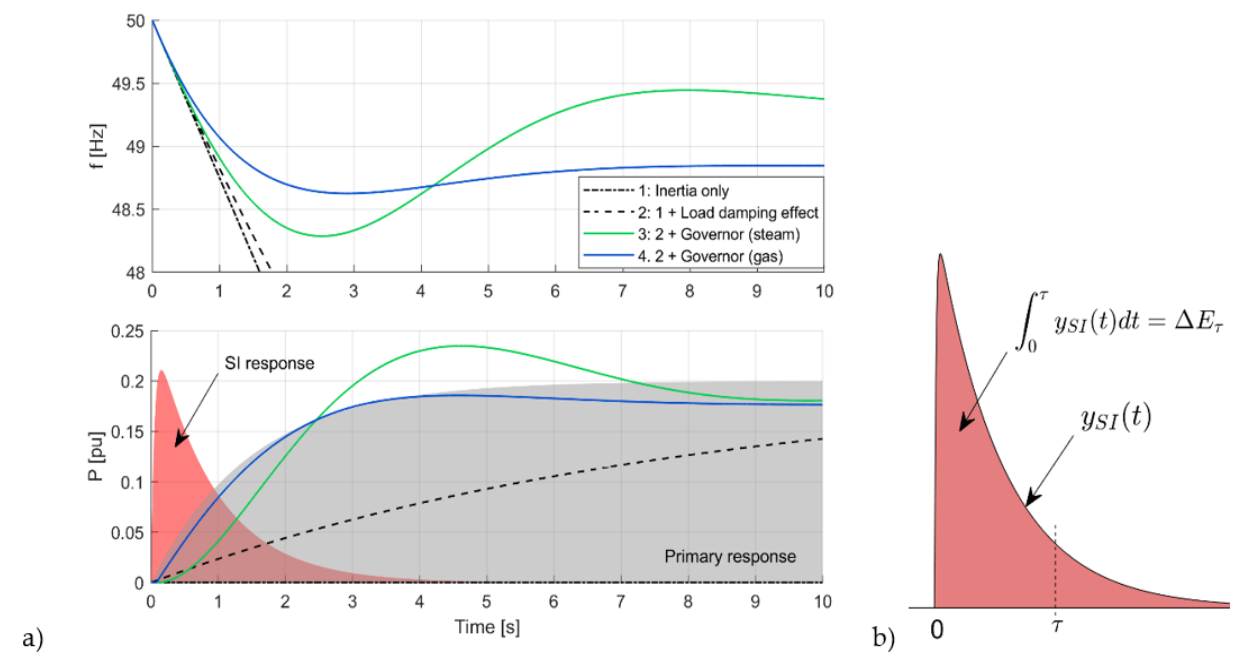
Figure 3. ( a ) Response to generation trip (0.2 pu) of 1. purely inertial system (dash–dot line), 2. inertial system with power-frequency load characteristics, 3. as in 2 with simplified steam turbine with governor added, 4. as in 2 with simplified gas turbine with governor added; ( b ) shape of time response of G SI (s).